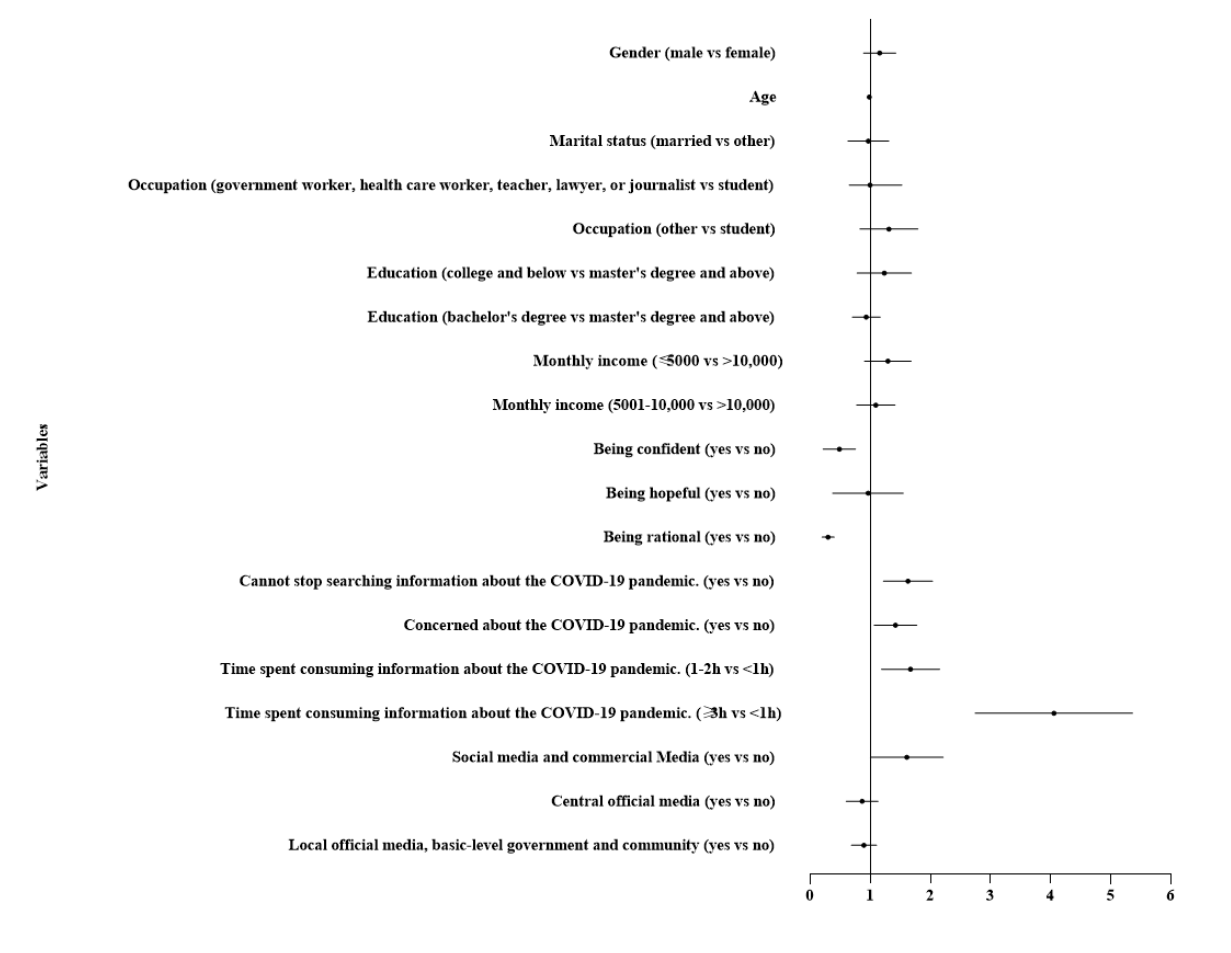
Figure 1. Forest plot of factors associated with